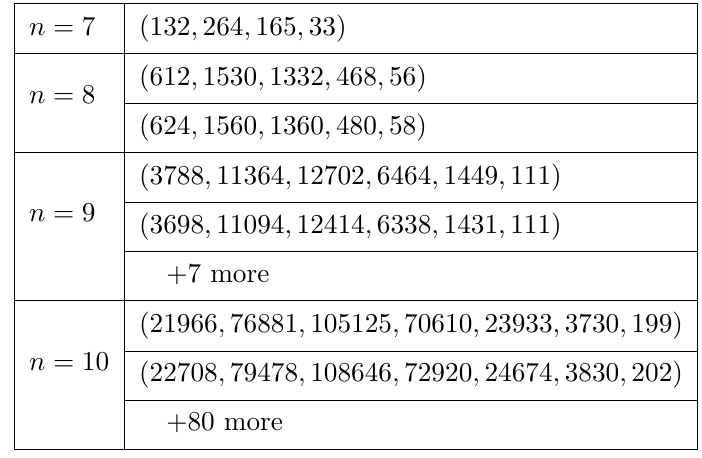
Table 2. All f -vectors corresponding to triplet sets listed in table